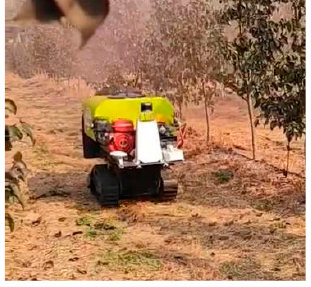
Figure 15. Test site.